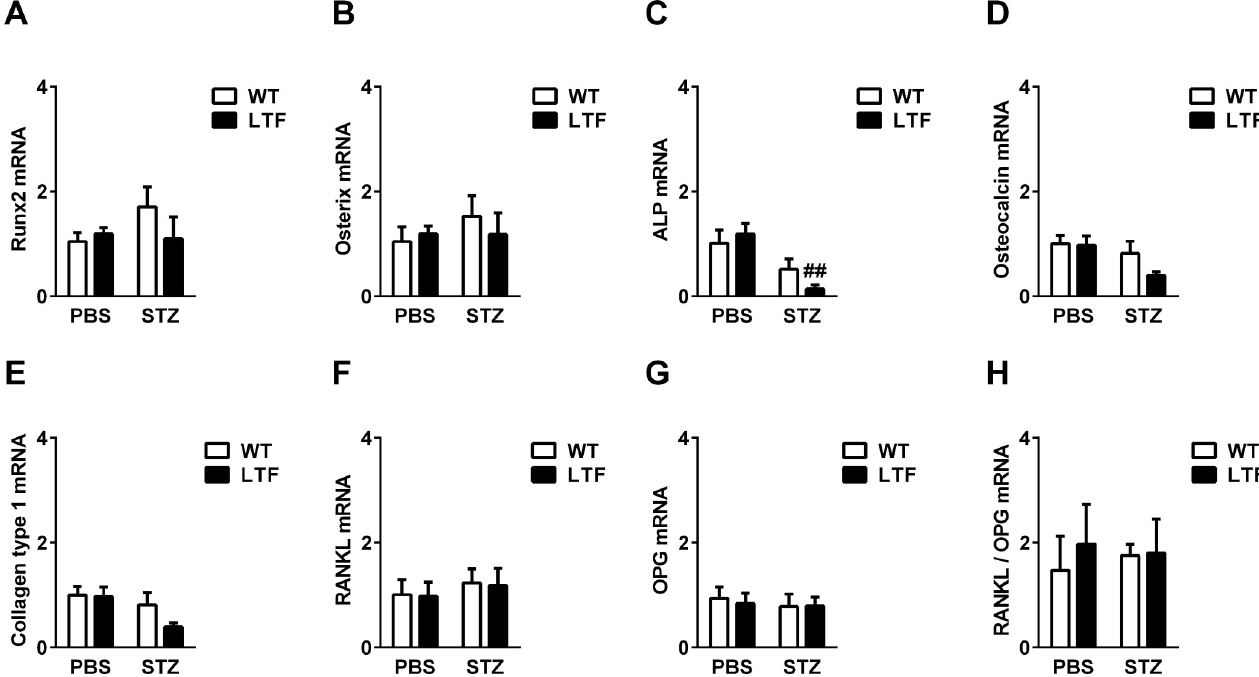
Fig 3. Effects of a diabetic state and TF deficiency on osteogenic and osteoclast-related gene expression. Injured femoral bone samples were extracted 7 days after bone defects from WT and LTF mice treated with or without STZ. Real-time PCR analyses of the mRNA expression levels of Runx2 (A), osterix (B), ALP (C), osteocalcin (D), type 1 collagen (E), RANKL (F), and OPG (G) were conducted, and levels were normalized to β -actin mRNA levels. The expression ratio of RANKL and OPG was also shown (H). Data represent the mean ± SEM of 6 mice. ## P < 0.01, significantly different from the PBS control.